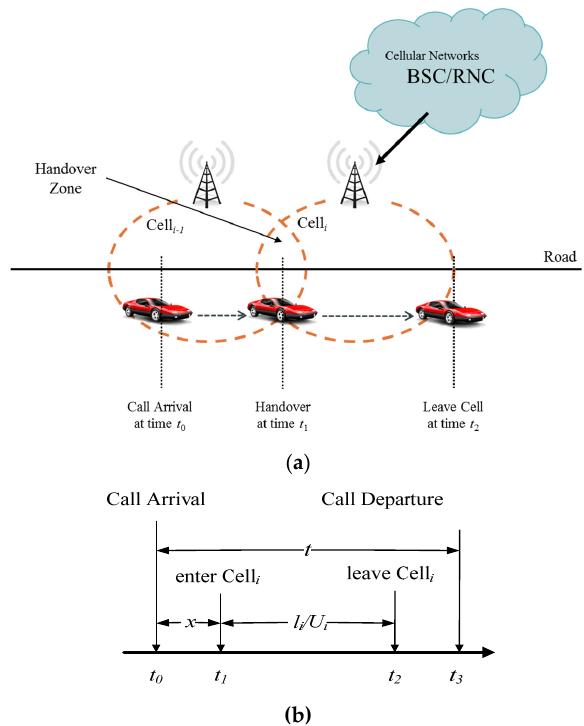
Figure 1. ( a ) The scenario diagram for vehicle movement and the handover on the road; ( b ) the timing diagram for the handover on the road segment covered by Cell i . BSC, base station controller; RNC, radio network controller.